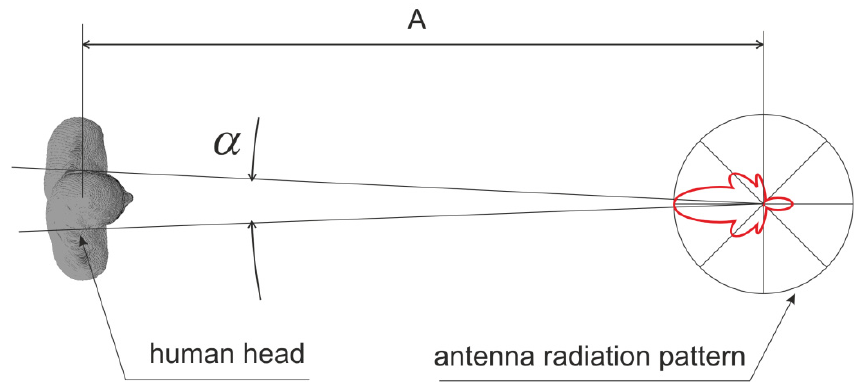
Figure 2. Human head exposure related to the base station antenna.